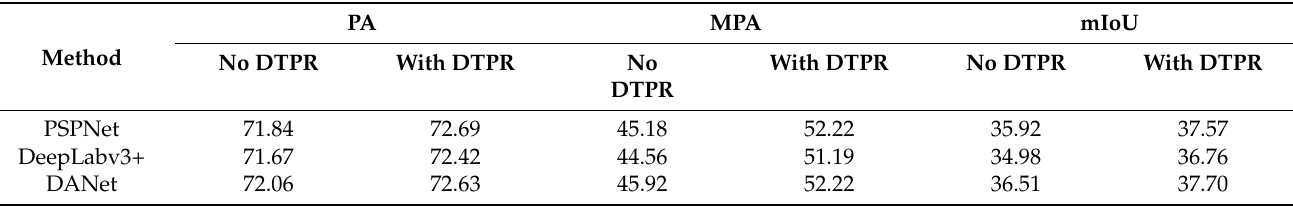
Figure 5. Comparison of IoU between PRA and PRN in some categories on the MHPv2.0 validation set. Table 2. Comparison of three SOTA models on the MHPv2.0 validation set.